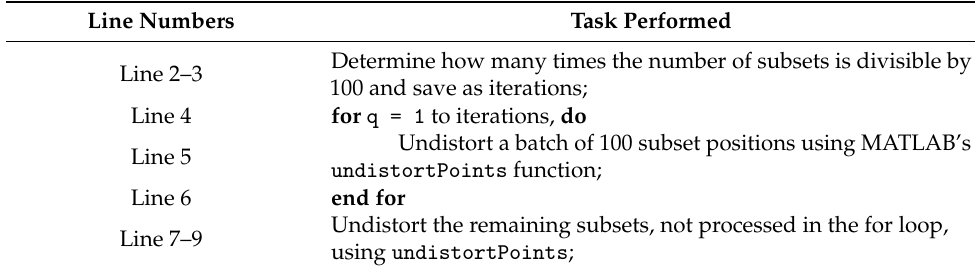
Table A1. UndistortPasser algorithm